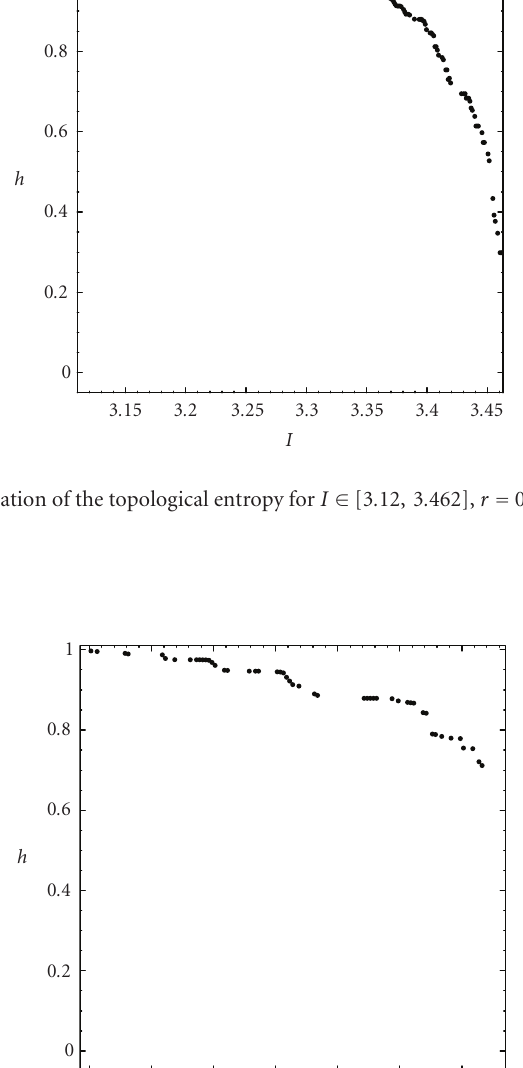
We note that the Hindmarsh-Rose model exhibits a chaotic behavior in a certain range of the parameters. The topological entropy allows us to quantify the orbit complexity and to extract the order from